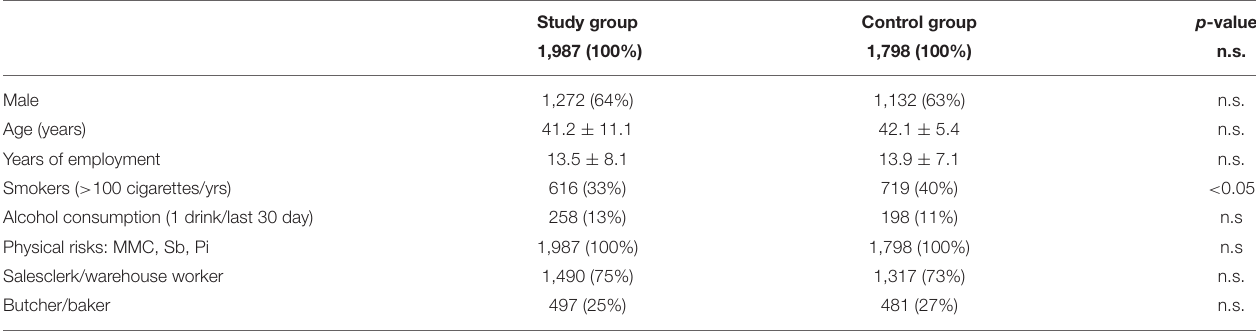
TABLE 2 | Main sample characteristics.